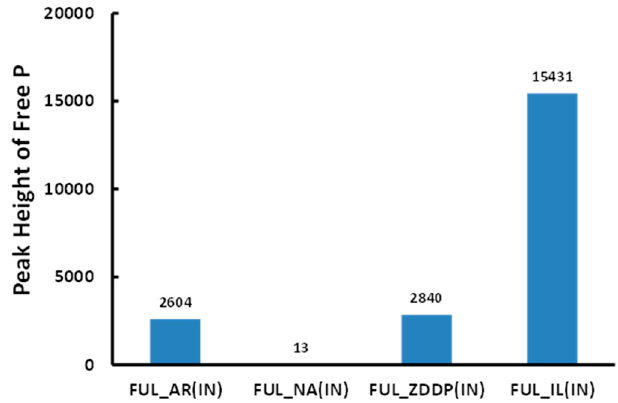
Figure 5. Electrospray analyses of the P species that weakly bond with TWC washcoat.